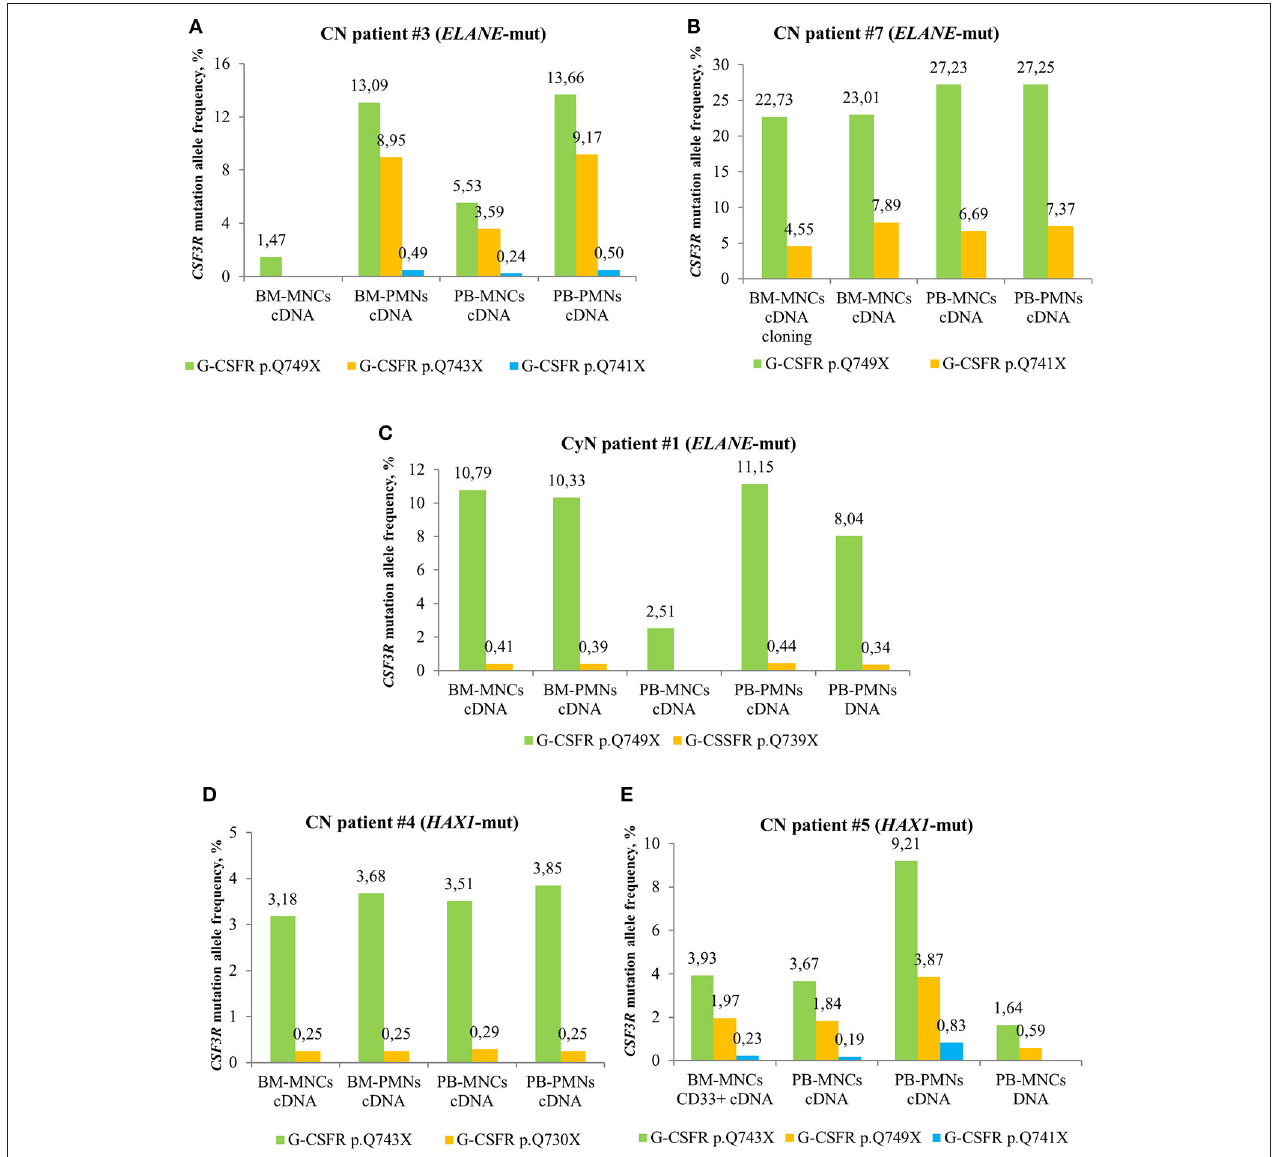
FIGURE 3 | Comparison of deep sequencing results in different types of peripheral blood (PB) and bone marrow (BM) samples of CN and CyN patients. Frequency of CSF3R mutant clones in different types of PB and BM samples from ELANE -CN patients (A,B) , CyN patient (C) and HAX1 -CN patients ( D,E ) was analyzed using cDNA deep sequencing, as described in Material and Methods section. The CSF3R mutant clones are indicated based on the relative amino acid positions of mutations.